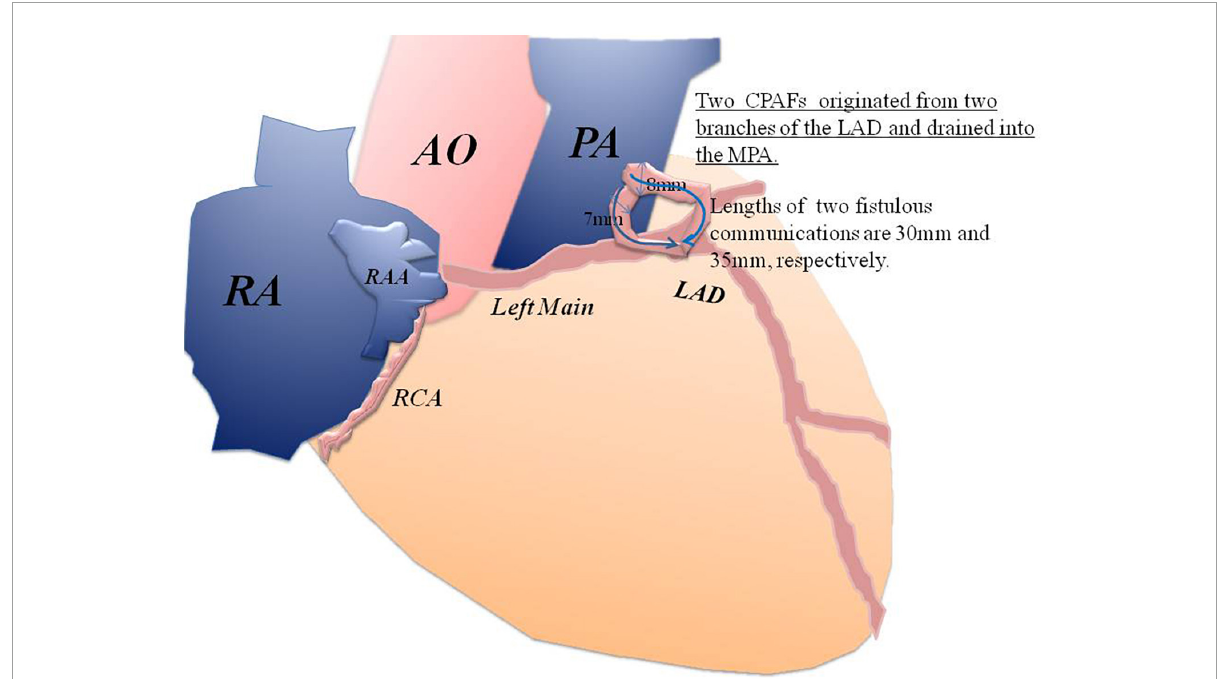
FIGURE4 A sketch of the two CPAFs that originated from two branches of the LAD and drained into the